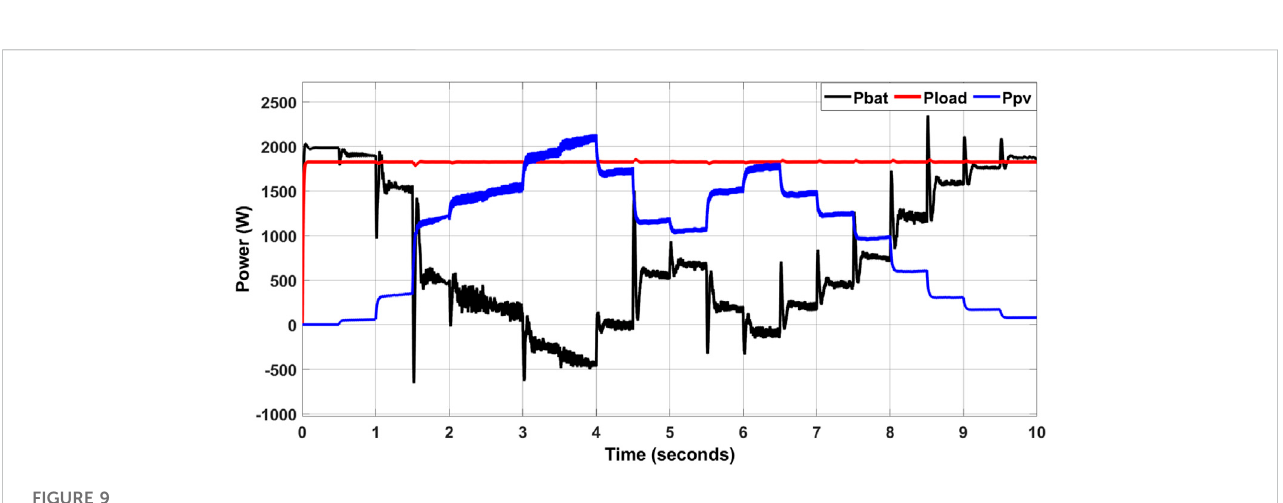
FIGURE 9 Power graphs of the PV system, load, and battery.